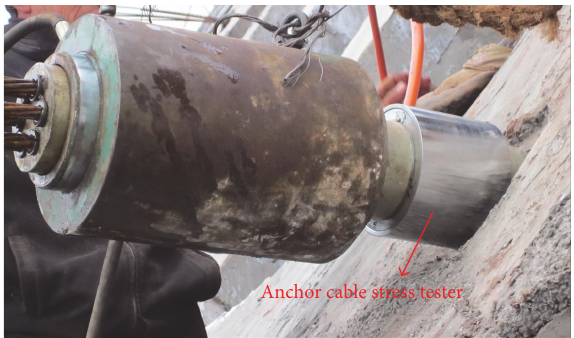
Figure 14: Anchor cable stress